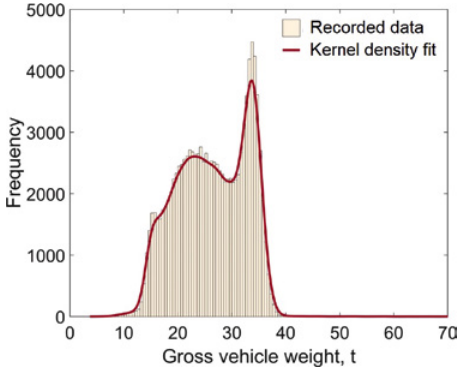
Figure 4. The distribution of gross weight for Segment